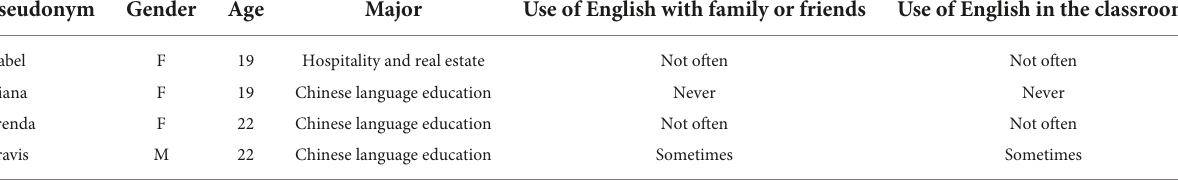
TABLE 1 Summary of participant